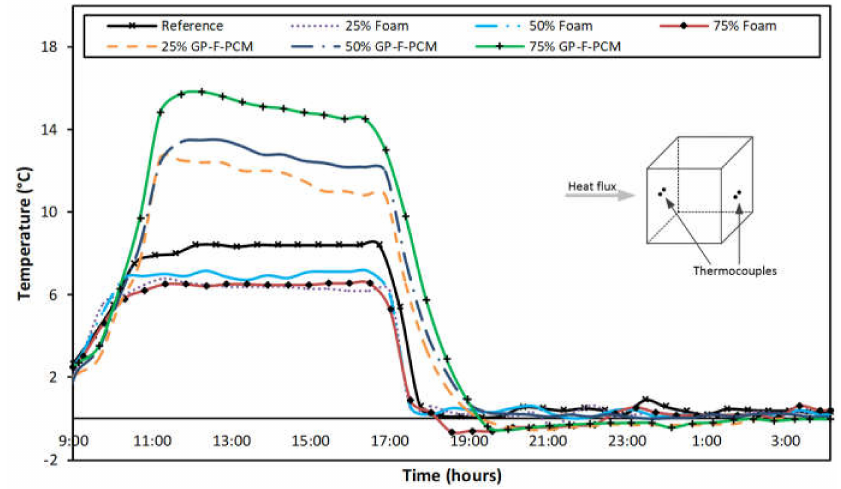
Figure 7. Differences in front-surface and back-surface